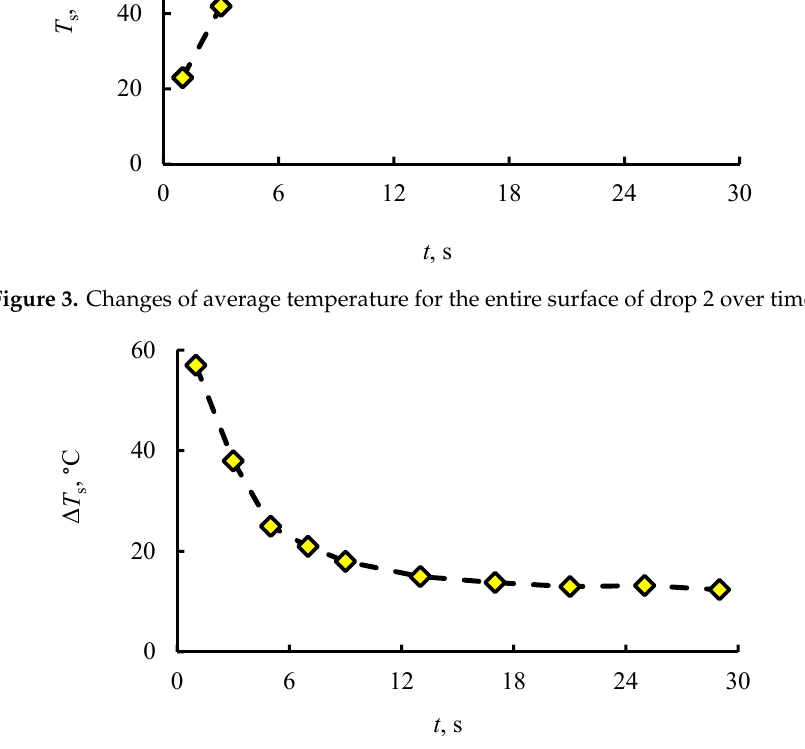
Figure 4. Changes in average temperature difference Δ T s for the entire surface of drop 2 over time.